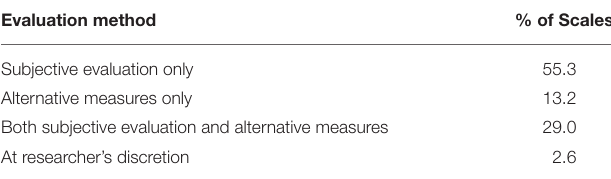
TABLE 7 | Evaluation methods used by the